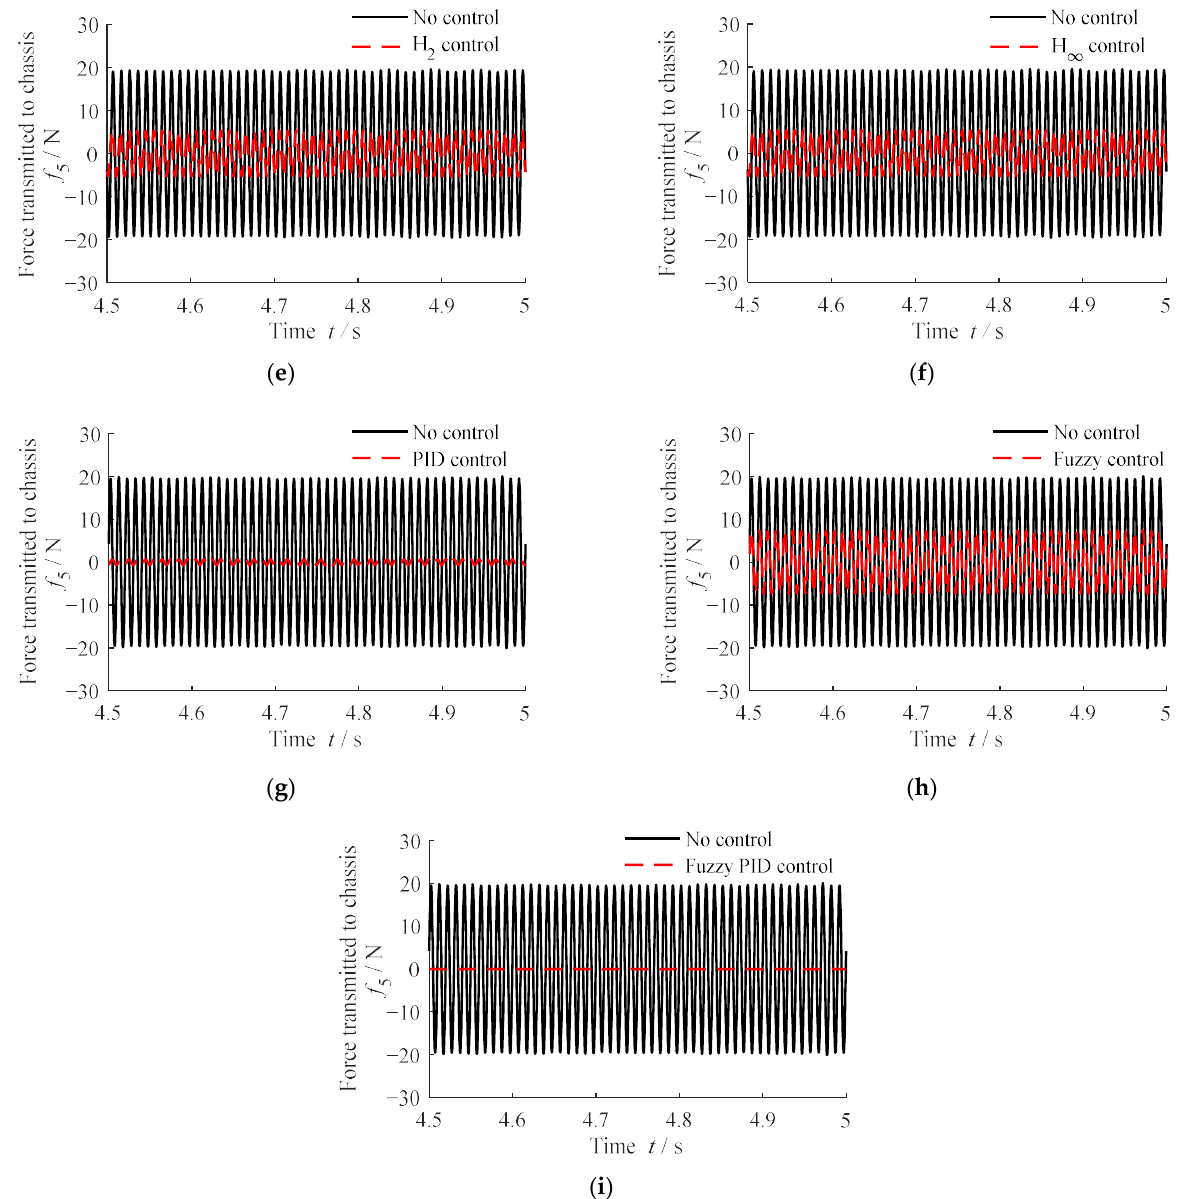
Figure 12. Comparison of transmitted force between nine control algorithms and no control at 3000 rpm.: ( a ) LMS; ( b ) RLS; ( c ) F x LMS; ( d ) LQR; ( e ) H 2 ; ( f ) H ∞ ; ( g ) PID; ( h ) Fuzzy; ( i ) Fuzzy PID. Table 4. Force transmissibility of each control algorithms at 3000